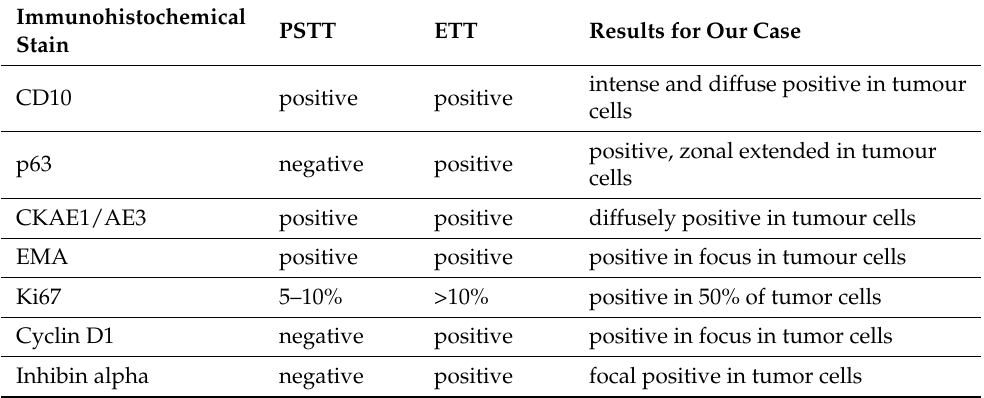
Table 2. Summary of immunohistochemical stains ETT versus PSTT with results for the case